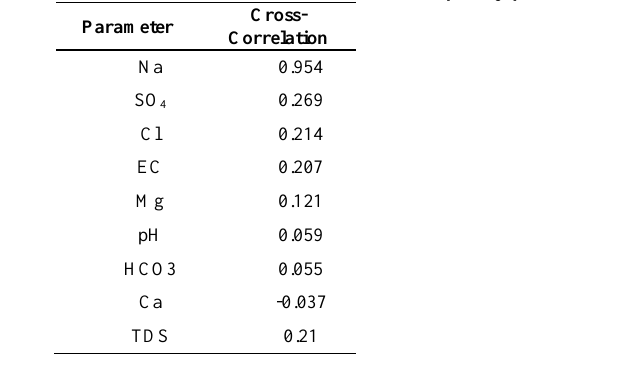
Table 3. Cross-correlation coefficient between SAR and other water quality parameters.